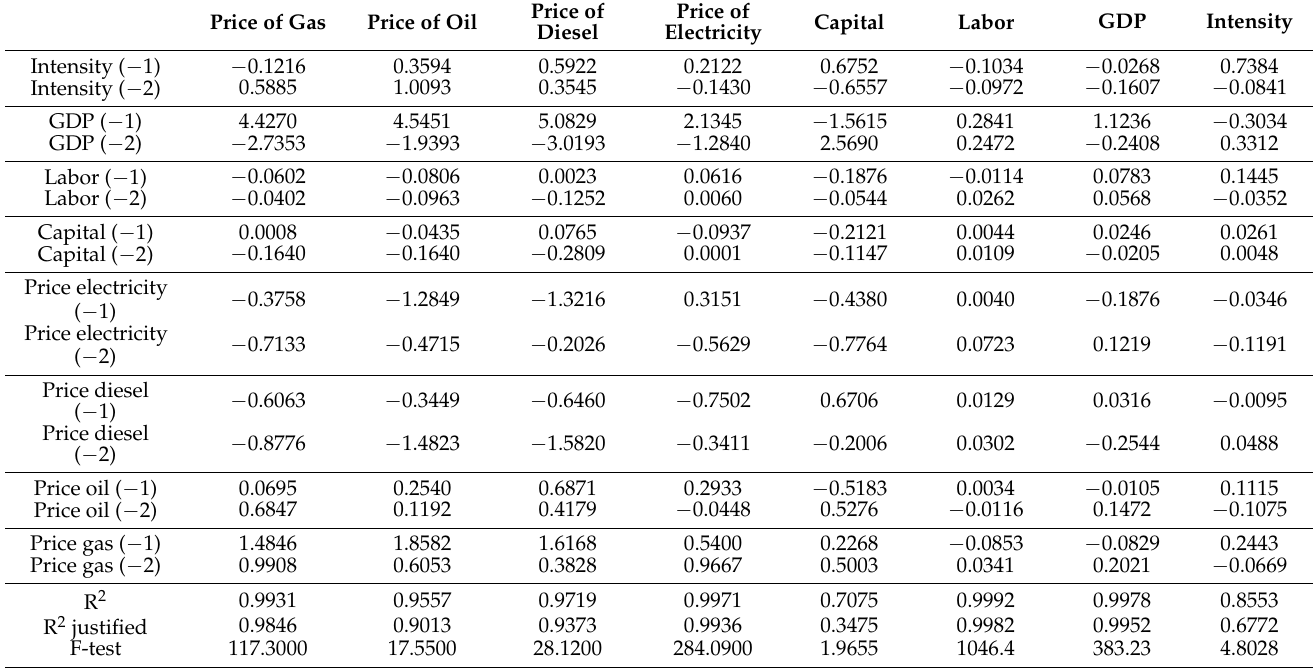
Table 5. Initial results of the developed autoregressive